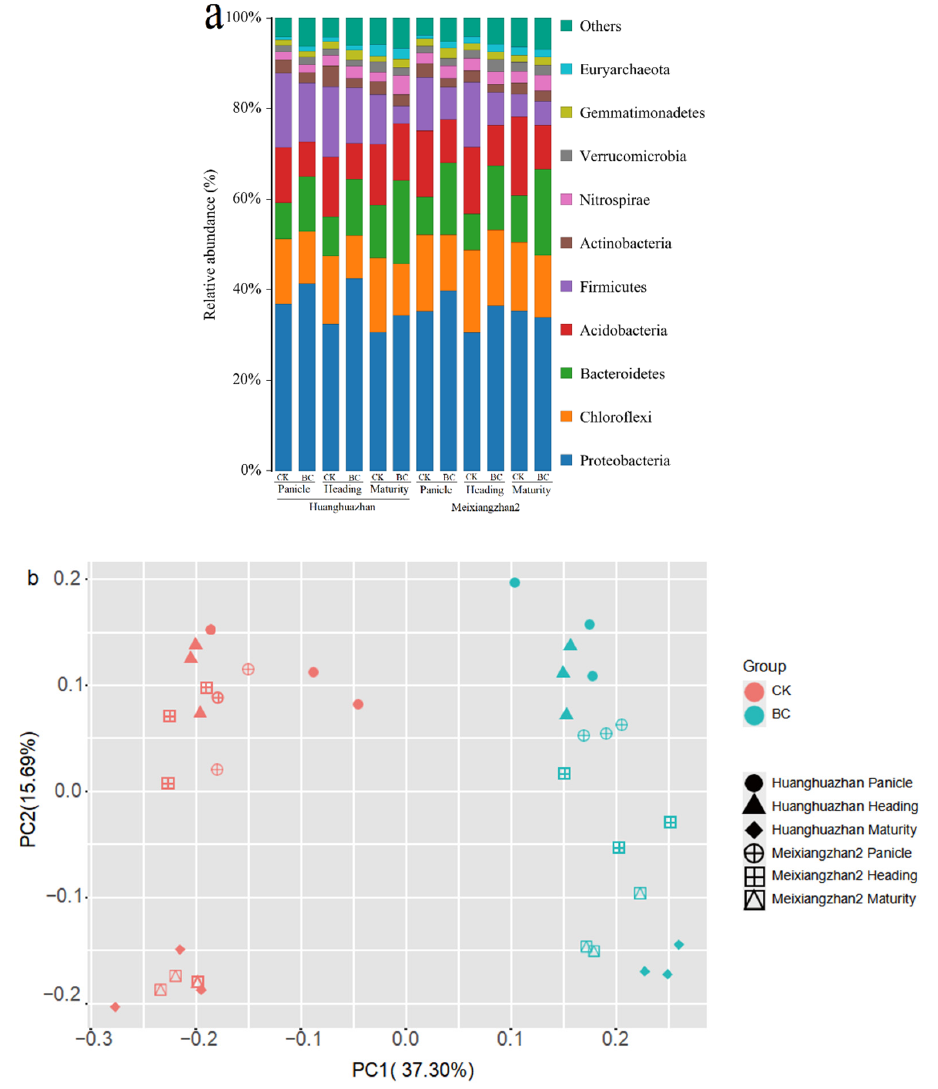
Figure 3. Mean relative abundance of microbe phyla in different conditions ( a ). Principal coordinate analysis (PCoA) ( b ) of microbes in different conditions using the Bray–Curtis metric. The x- and y-axes in panel ( b ) are indicated by the first and second coordinates, respectively, and the values in parentheses show the percentages of the community variation explained.